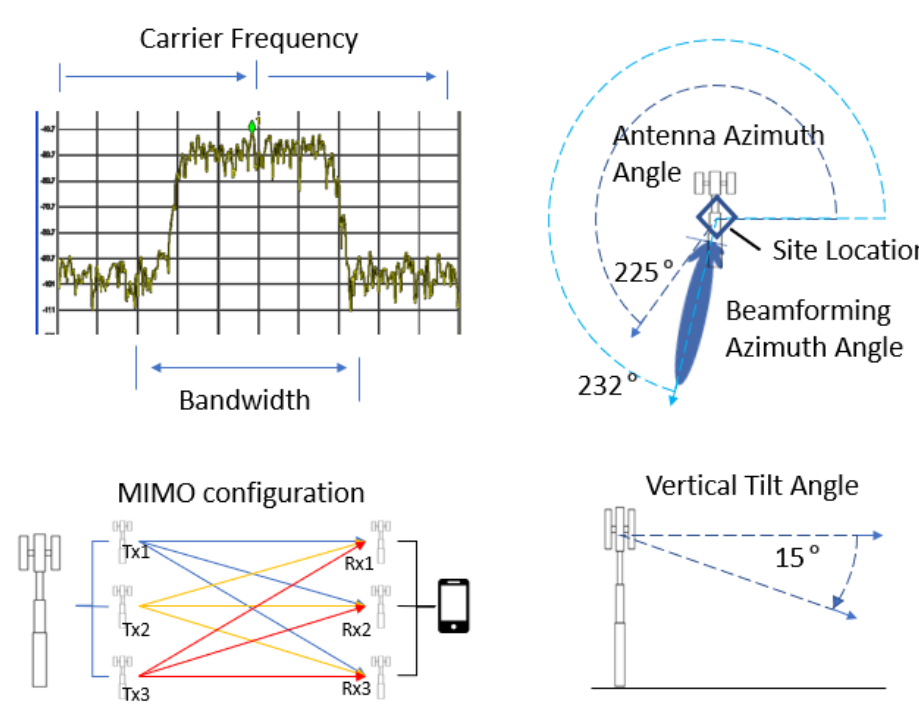
Figure 1. Adjustable 5G cell/site